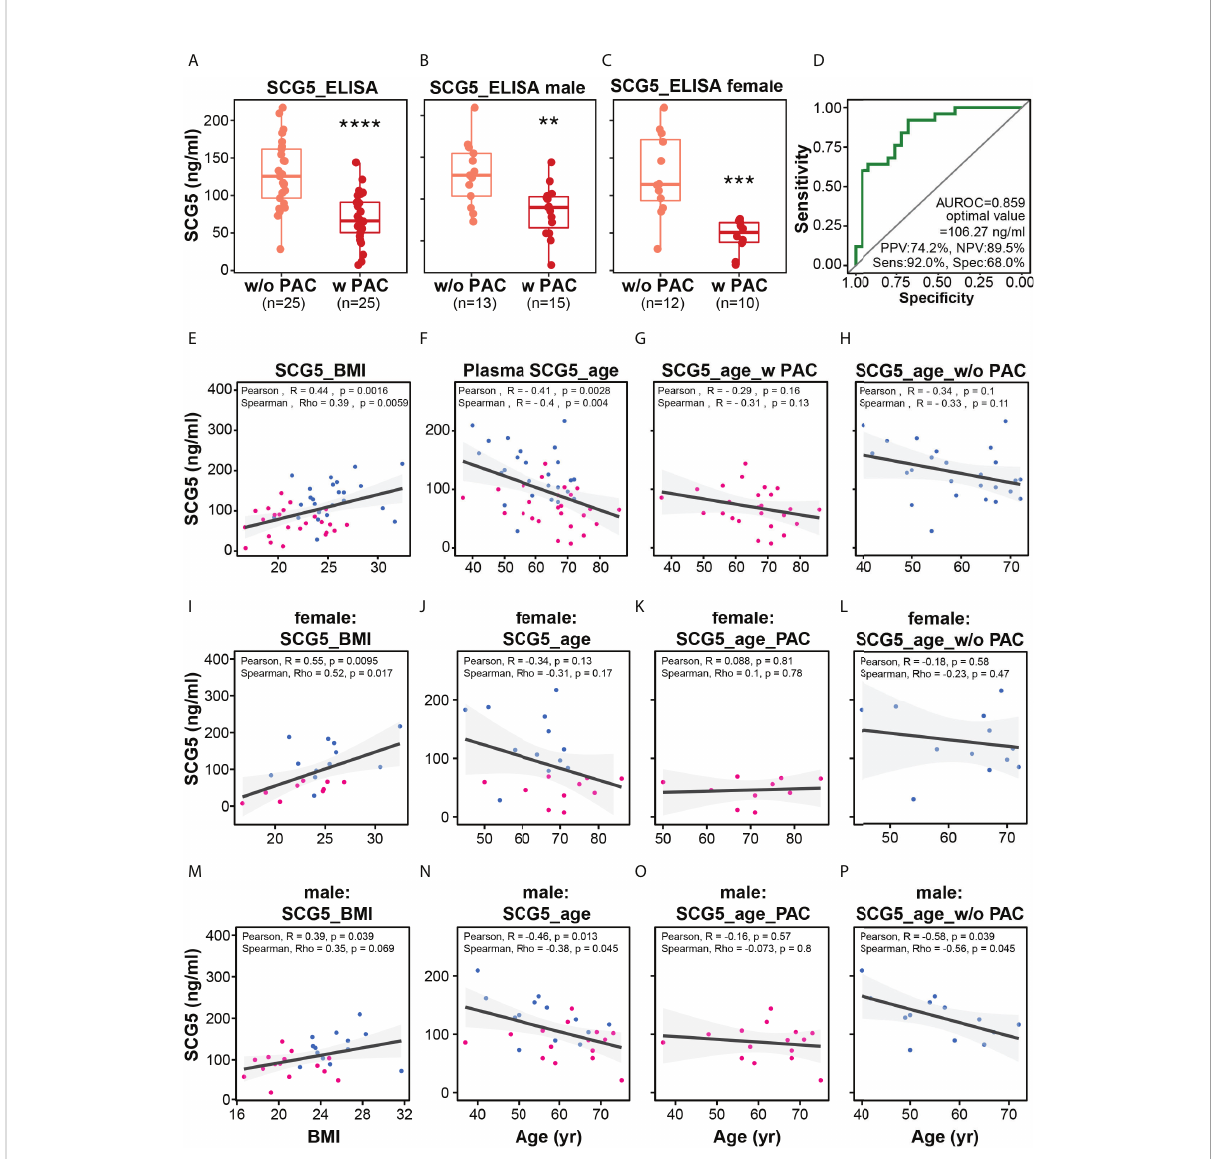
FIGURE 4 Plasma level of SCG5 distinguishes patients with PAC from those without PAC. (A) Plasma level of SCG5 in patients with PAC and those without PAC. (B, C) Plasma level in (B) male and (C) female participants. The boxplots (A – C) present the 25% quartile, the median, and 75% quartile. Student ’ s t- test computed the statistical signi fi cance. ****p < 0.0001, ***p < 0.001; **p < 0.01. (D) Receiver operating characteristic curve proposing optimal cut-off value (106.27 ng/ml) distinguishing patients with PAC from those without PAC. (E – H) Scatter plots estimating correlations between plasma SCG5 and BMI (E) or age (F – H) . (I – O) Scatter plots showing correlations between plasma SCG5 and BMI (E) or age in females (I – L) and males (M – P)